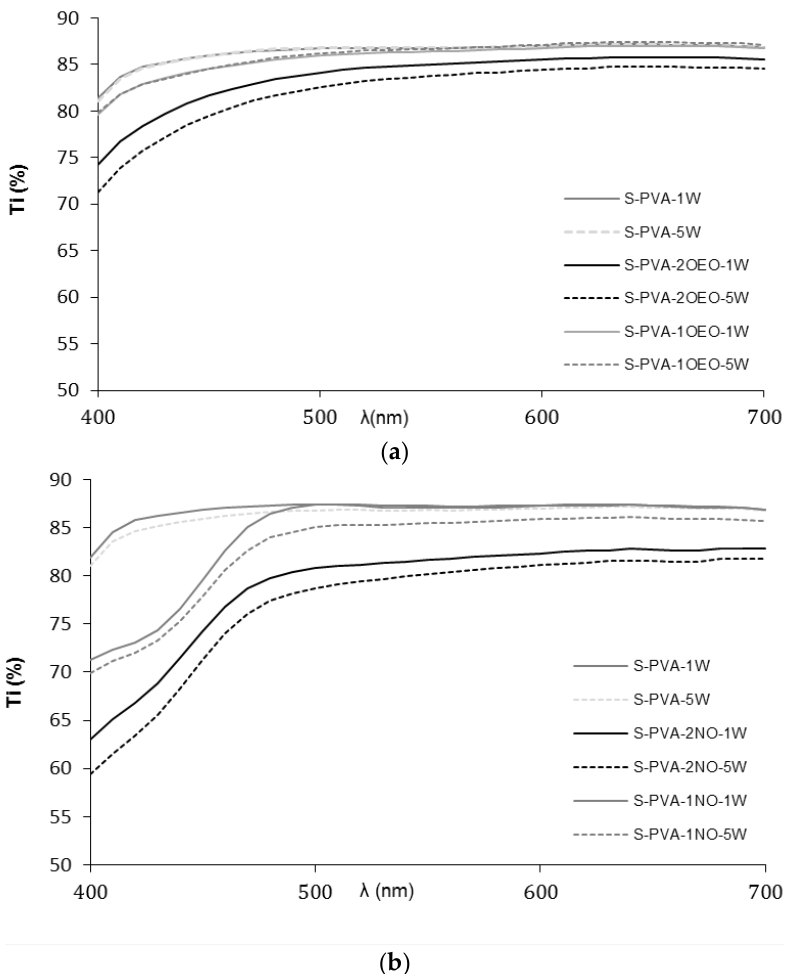
Figure 2. Internal transmittance of control and composite films: ( a ) films containing oregano essential oil (OEO) and ( b ) films containing neem oil (NO) after one (1W) and five weeks (5W) of storage.